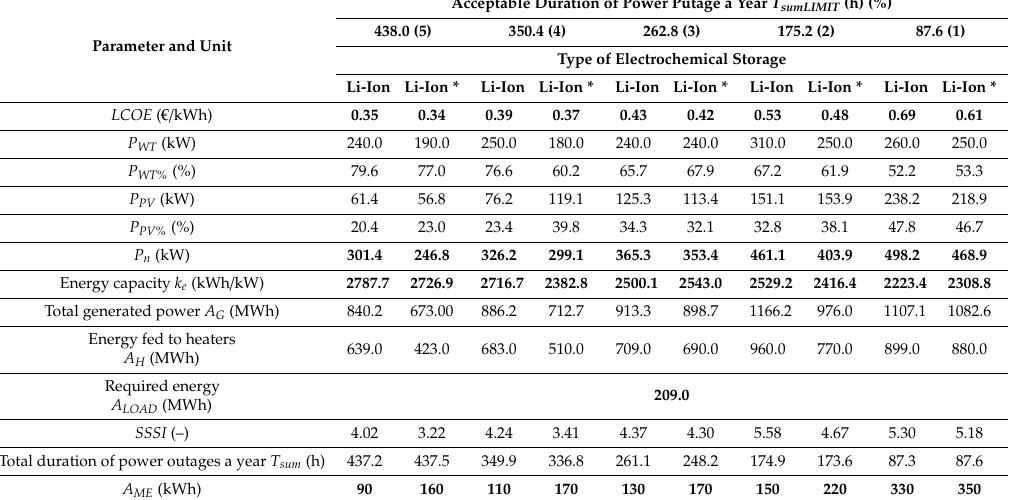
Table 8. Comparison of the results of PV-wind hybrid power supply system structure optimization for lead–acid storage with the current and future (*—five years perspective) prices and parameters for a 50 kW peak power industrial load with no limit for the power generation system rated power P n (for: I ESPb = I ESLi-Ion = 533.3 € / kWh, M ES = 22.2 € / kWh, I ESLi-Ion = 426.7 € / kWh, M ES = 22.2 € / kW,